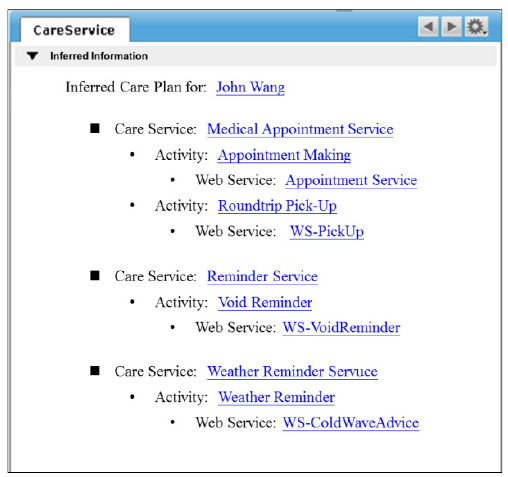
Figure 14. Inferred information page of care services.